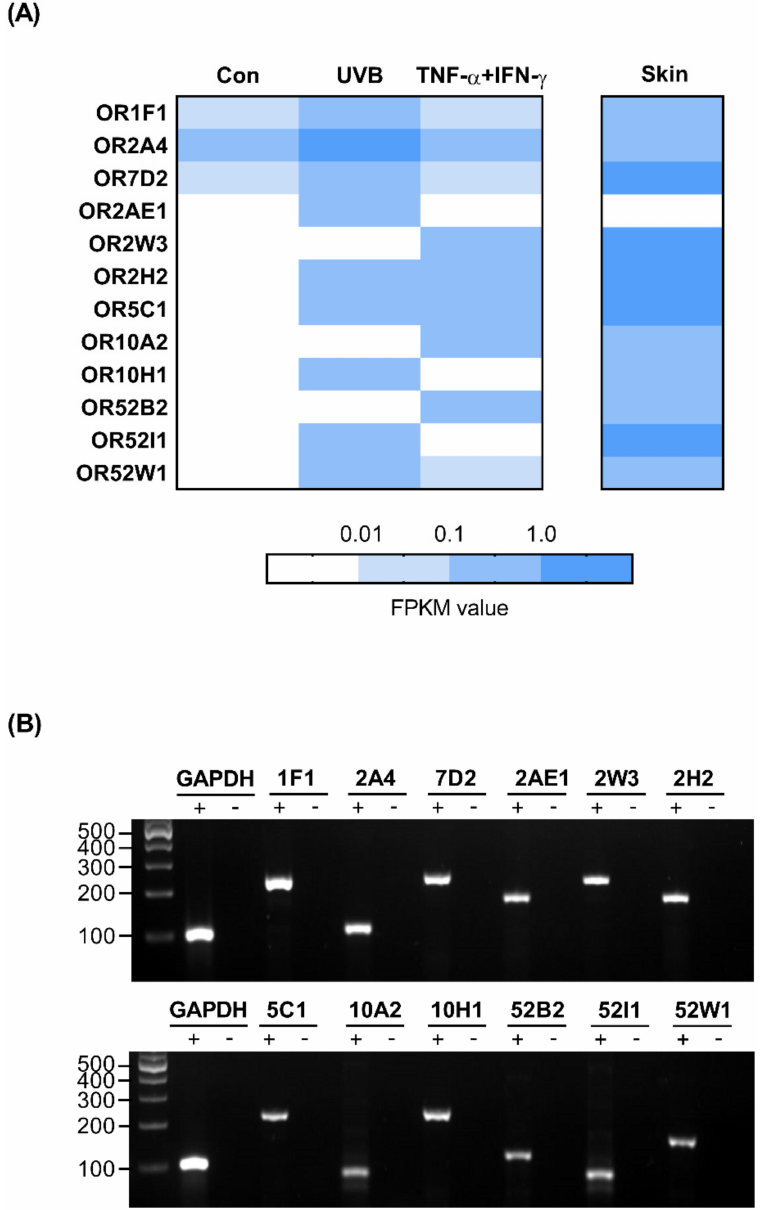
Figure 4. Olfactory receptor (OR) profile in HaCaT cells. ( A ) The heat map shows fragments per kilobase of exon per million fragments mapped (FPKM) values for the 12 highly expressed ORs found in the HaCaT cells and skin tissues. Dark blue represents high transcript expression, and white indicates low to no detectable transcript expression. ( B ) RT-PCR for verifying OR1F1 , OR2A4, OR7D2, OR2AE1, OR2W3, OR2H2, OR5C1, OR10A2, OR10H1, OR52B2, OR52I1, and OR52W1 expression in HaCaT cells. The housekeeping gene glyceraldehyde 3-phosphate dehydrogenase ( GAPDH ) was used for cDNA quality control. The mRNA samples converted into cDNA are shown as (+), and the negative controls containing mRNA are shown as ( − ). Numbers, length of fragments